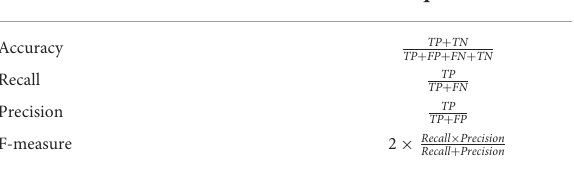
TABLE 1 Performance evaluation metrics equations. TABLE 2 LR prediction result of feature selection methods on original